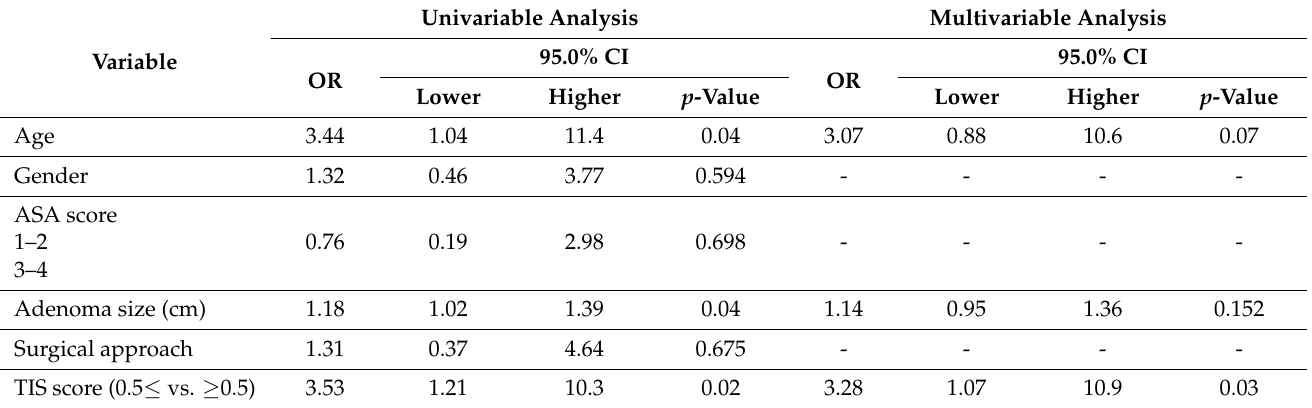
Table 6. Univariable and multivariable logistic regression analysis to identify predictors of trifecta